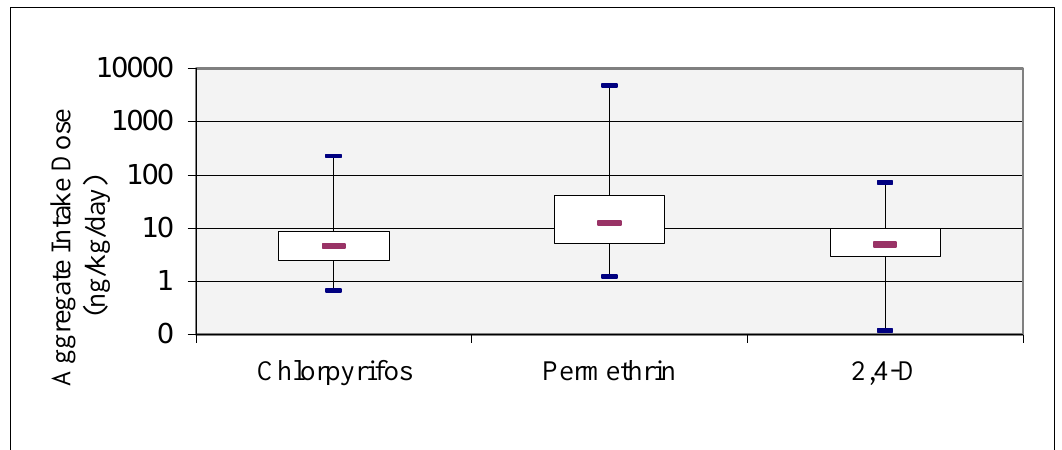
Figure 1. The children’s estimated potential aggregate intake doses to chlorpyrifos, permethrin, and 2,4-D a,b